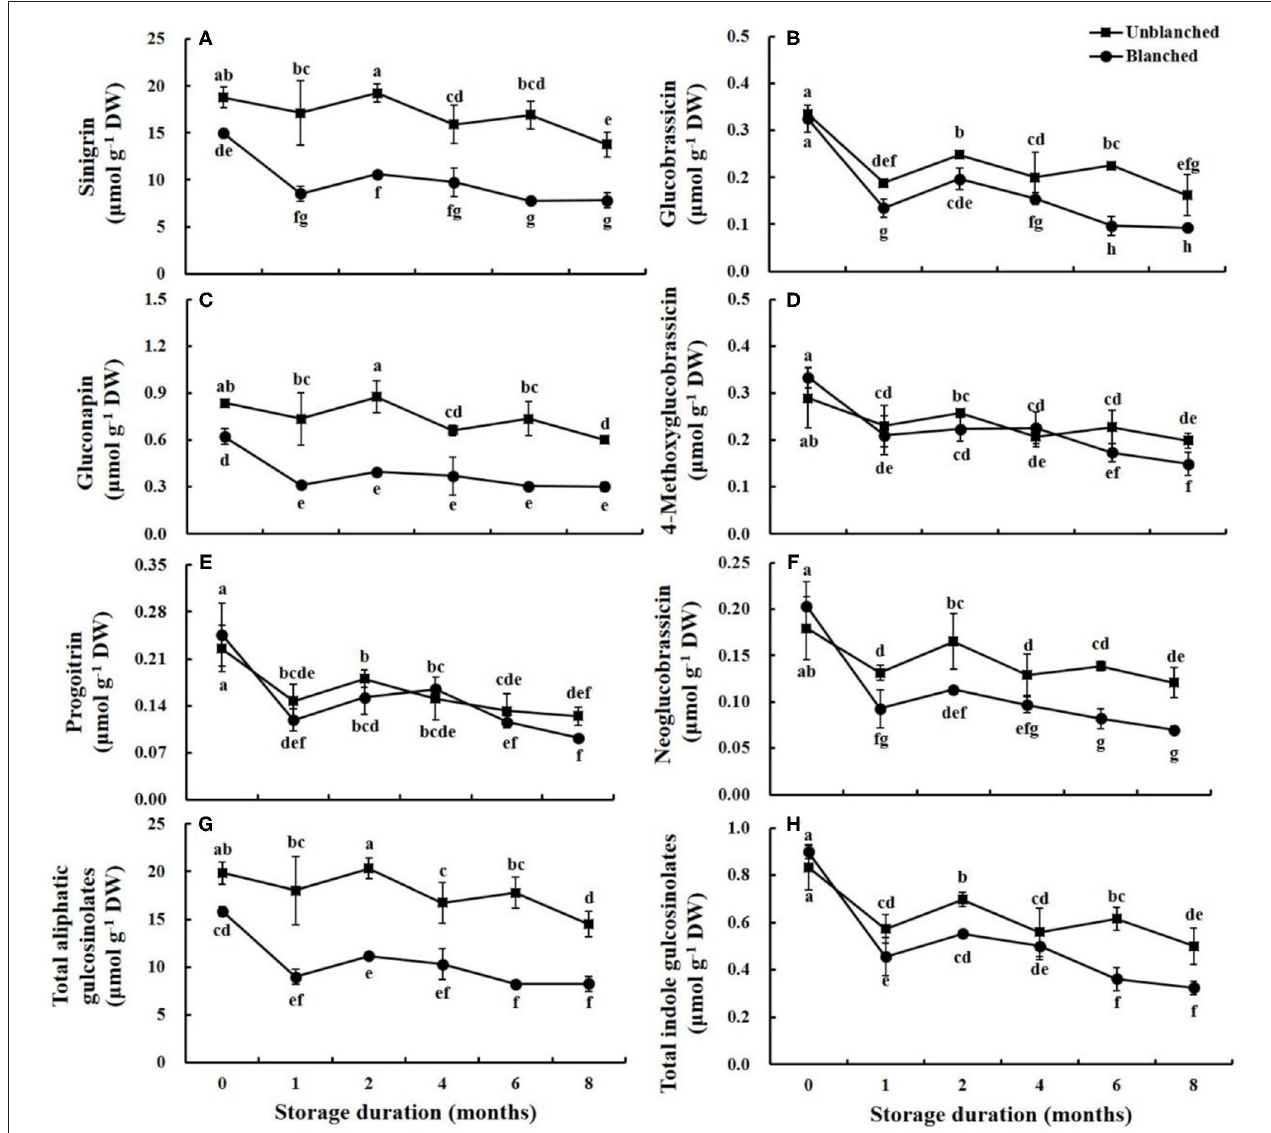
FIGURE 1 | Evolution trend of predominant glucosinolate content in baby mustard lateral buds during frozen storage at − 20 ◦ C. (A) sinigrin; (B) glucobrassicin; (C) gluconapin; (D) 4-methoxyglucobrassicin; (E) progoitrin; (F) neoglucobrassicin; (G) total aliphatic gulcosinolates; (H) total indole gulcosinolates. Unblanched represents no blanching before freezing; Blanched represents blanching before freezing. Values not sharing the same letter are significantly different at p <